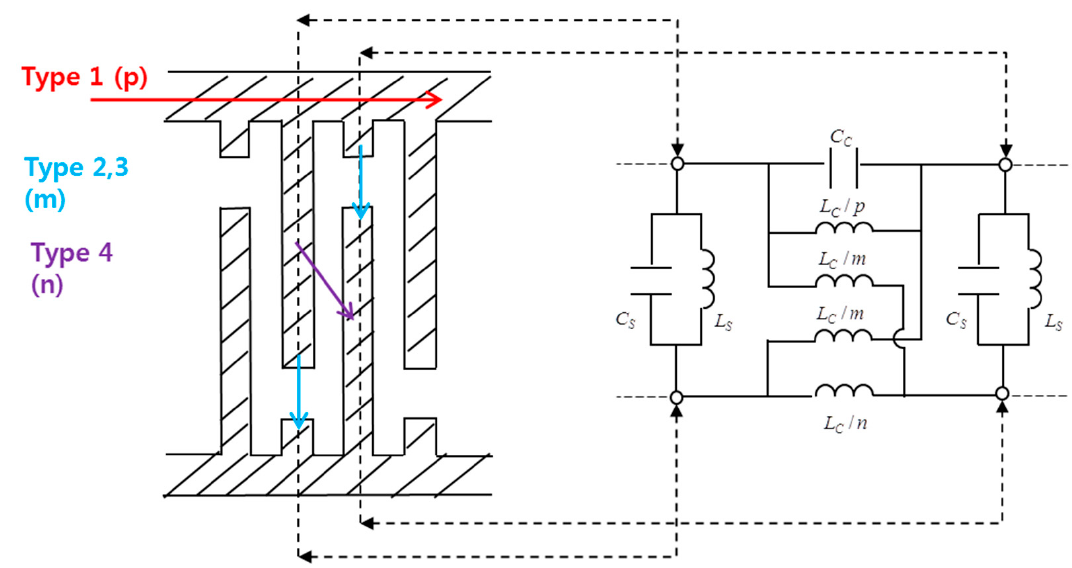
Figure 3. Equivalent circuit of the meander gap.